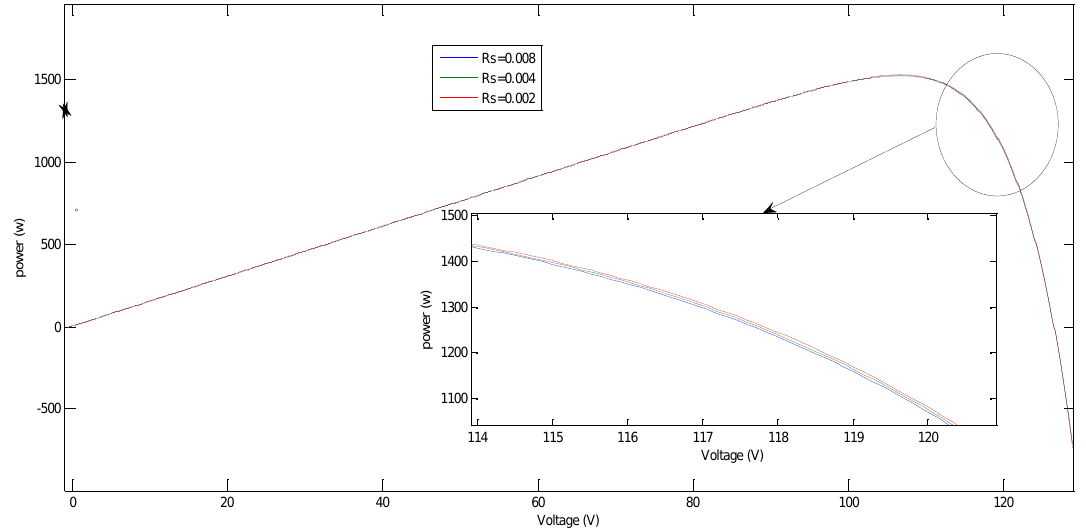
Figure 6. Effect of variation of series resistance on the characteristic of Photovoltaic (PV) cell: ( a ) I-V ch/s; and ( b ) P-V ch/s.